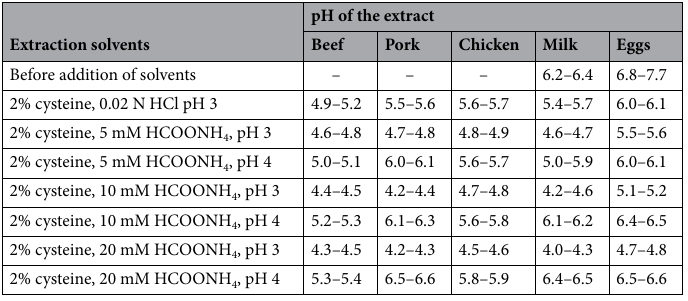
Table 2. Effects of various extraction solvents on the pH values of the livestock product extracts.